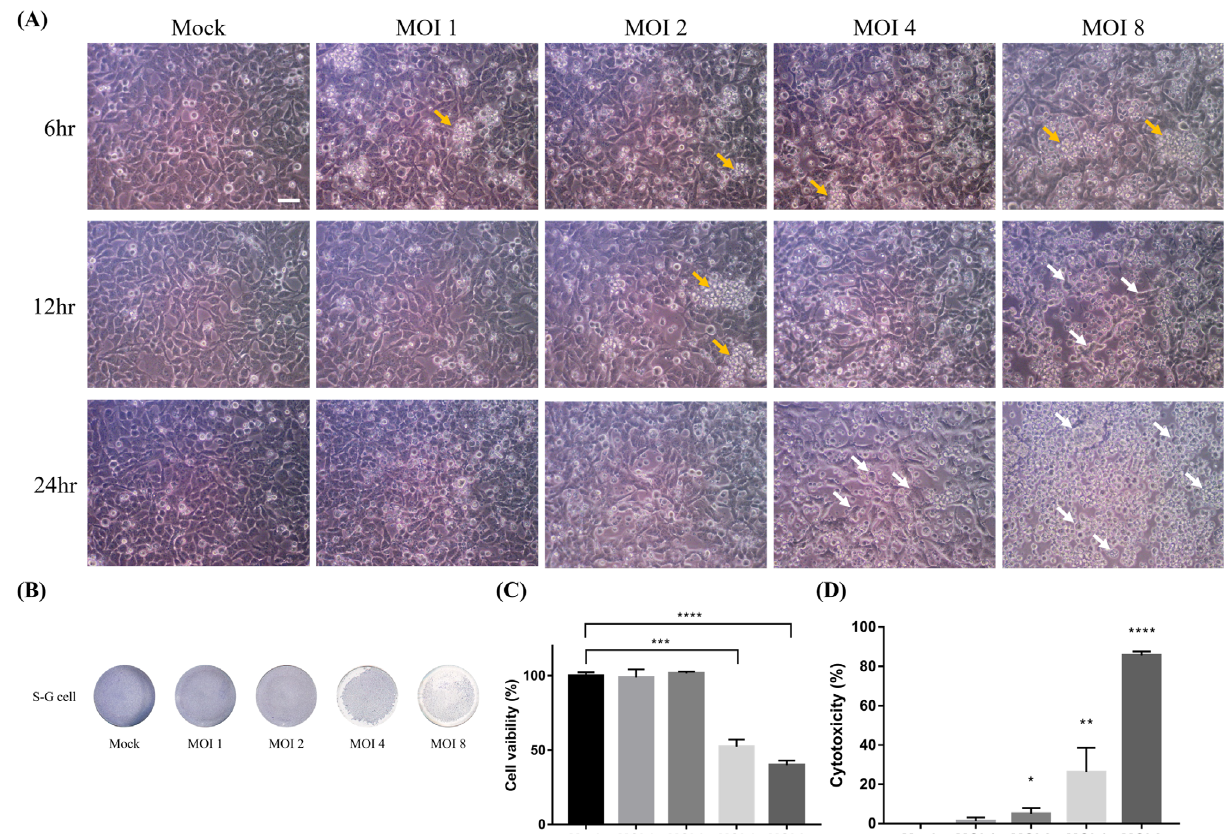
Figure 1. Induction of cell cytotoxicity during Trichomonas tenax incubation with S-G cells for 24 h. (A) The cell viability of S-G cells incubated with T. tenax at different MOIs (1, 2, 4, 8) for 6, 12, and 24 h was assessed using a microscope (Yellow arrow: aggregated T. tenax , white arrow: round S-G cell shape, Scale Bar: 50 l m). (B) The CPE of S-G cells co-incubated with T. tenax was observed by staining with Giemsa buffer in 24-well plated. (C) Stained cells were calculated by ImageJ. (D) Lactate dehydrogenase (LDH) cytotoxicity assay was performed on S-G cells after coincubation with T. tenax at different MOIs for 24 h (* p (cid:3) 0.05, ** p (cid:3) 0.01, *** p (cid:3) 0.001, **** p (cid:3) 0.0001, MOI: multiplicity of infection).